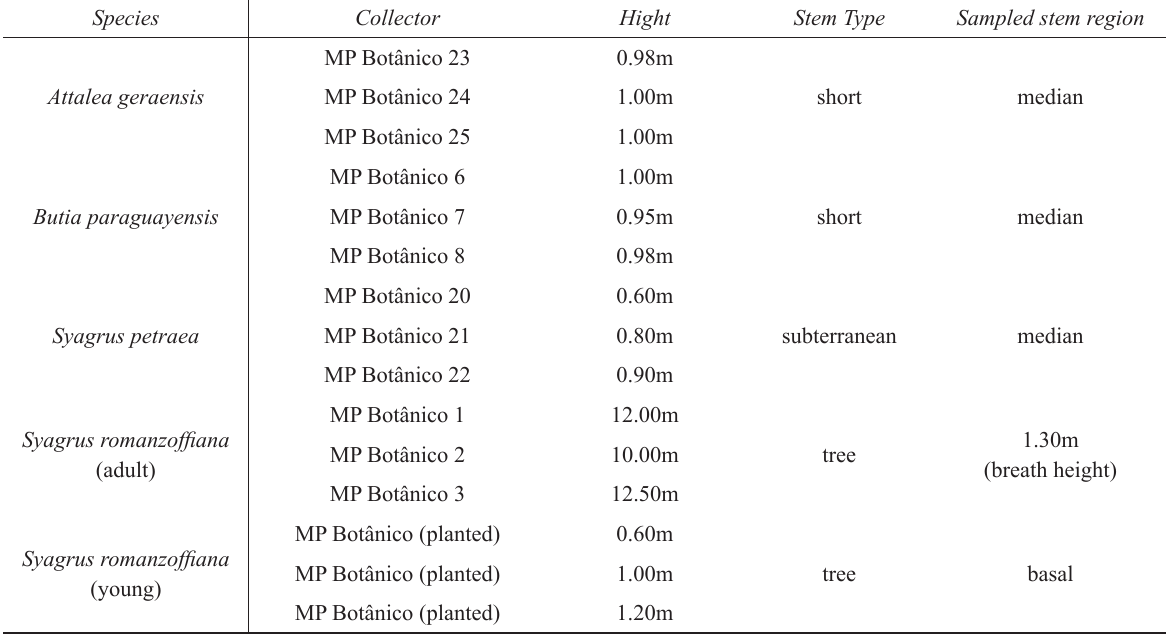
Studied species, collector data, stem characteristics and sampled stem